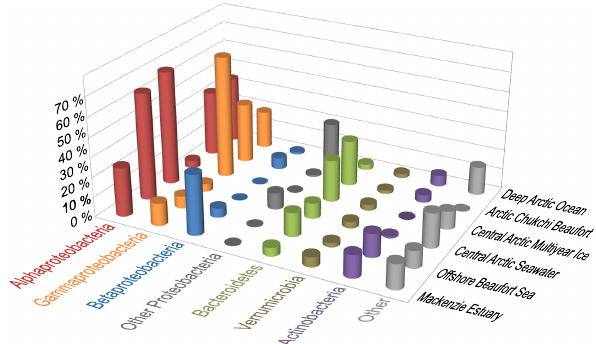
Figure 1. Relative abundance of major phyla identified in pyrose- quencing studies of the deep Arctic Ocean (Galand et al., 2010); the Arctic Chukchi Beaufort (Kirchman et al., 2010), the central Arctic multiyear ice and the central Arctic seawater (Bowman et al., 2012), the offshore Beaufort Sea and the Mackenzie estuary (Ortega-Retuerta et al.,